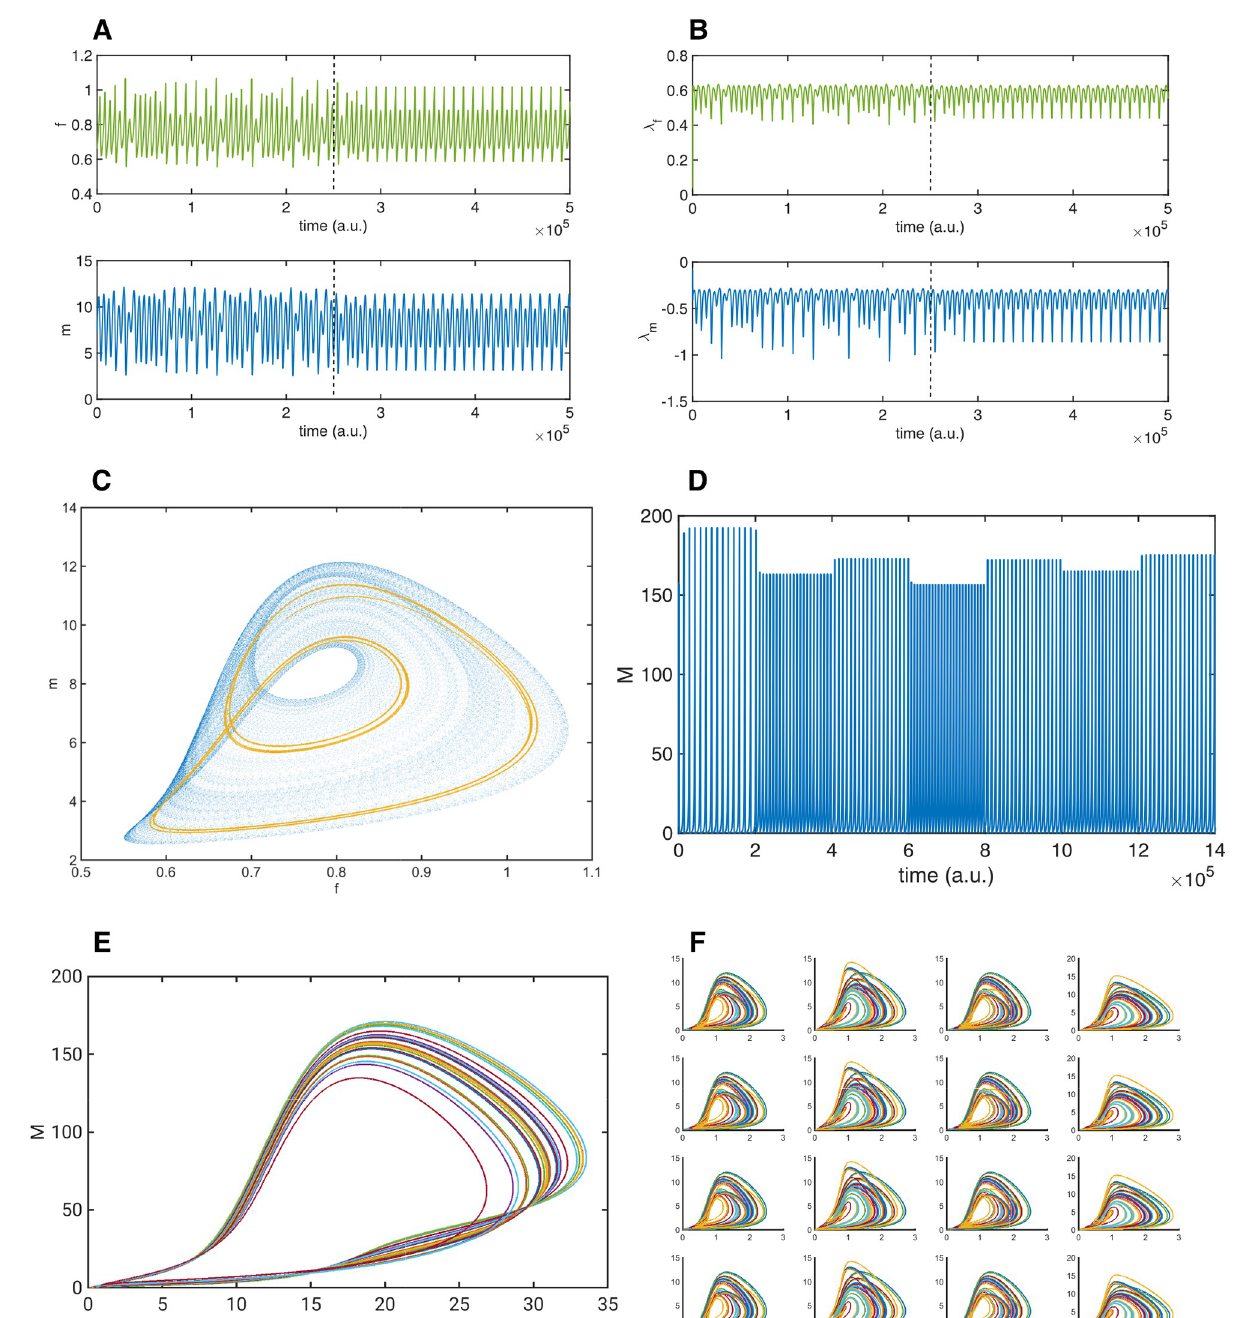
Fig 1. Dynamic controlled behaviour of the Berry model. A Example of the chaotic Berry model with control enabled at the dotted line, the system quickly stabilises into a two orbit. Top panel shows the modelled soluble filament f , the bottom panel the fixed matrix m in time. B Lyapunov estimates of the model in Fig 1A, showing small positive and small negative values. The control, enabled at the dotted line, does not eliminate the chaotic state, but changes the system into a stable oscillation. C Phase space plot of the chaotic model in blue, with the RCC controlled two orbit superimposed in gold, F versus M . D Total unweighted sum M from sixteen weakly coupled RCC controlled oscillators, with random external perturbations at fixed intervals showing 7 stable oscillations after very short transients. E Phase space plot F versus M , of 24 stable oscillations based on the total unweighted sum of the sixteen weakly coupled oscillators. Each coloured line is a single stable oscillations, as can be seen in time in Fig 1D. F Phase space plots of the sixteen systems F versus M , where each coloured line is a single stable oscillation, different due to the random external perturbations (transients